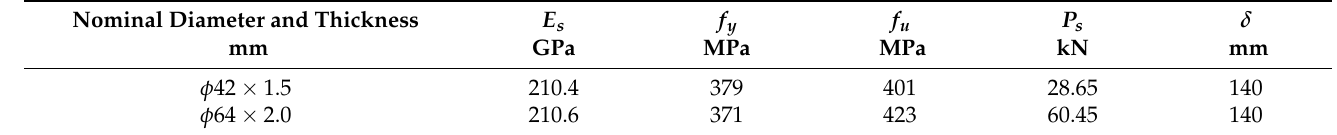
Table 1. Mechanical characteristics, steady force and stroke of the steel